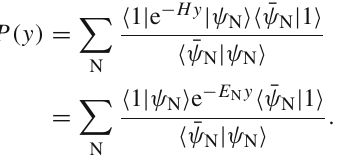
Fig. 4 Logarithmicplotoftheratio E 1 /λ forthefirsteigenvalue N = 1 as a function of positive μ/λ . The solid line shows theoretical value, small squares mark computed numerical